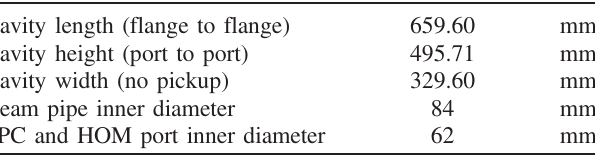
TABLE I. General geometry dimensions of the SPS-series DQW cavity at an ambient temperature (includes the wall thickness).